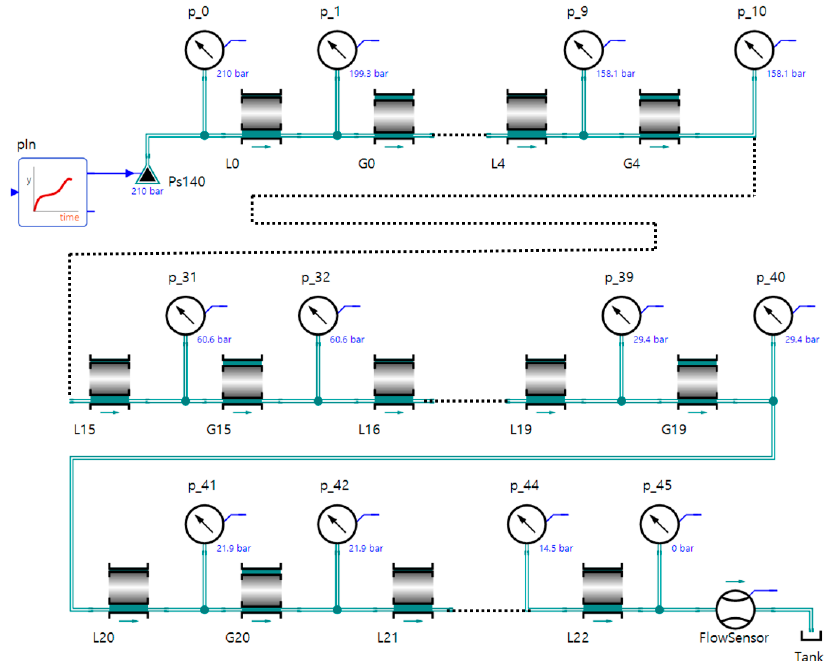
Figure 8. Modeling of labyrinth seal for piston.